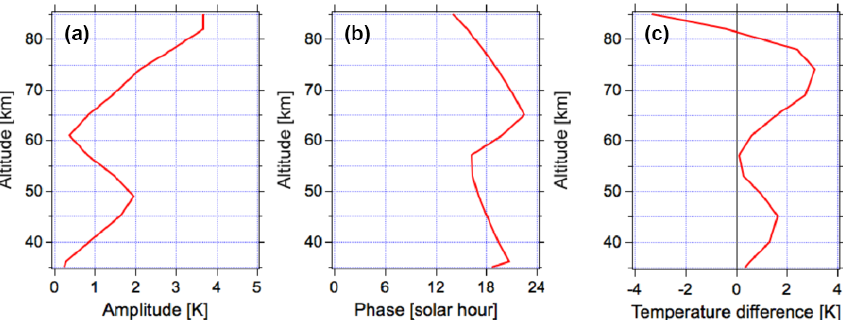
Figure 5. Amplitude (a) and phase (time of the maximum temperature; c ) of the diurnal tides extracted from the GSWM above 45 ◦ N for August. Temperature differences (lidar minus GOMOS; b ) expected from diurnal atmospheric tides as simulated by the GSWM-00